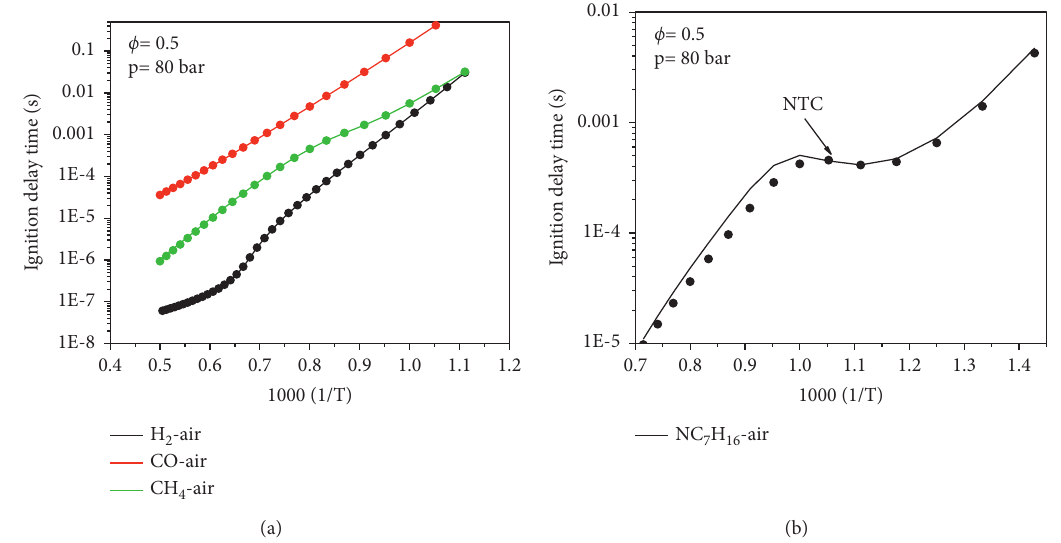
Figure 2: Comparison between the ignition delay time of the CSU mechanism (solid line) and the detailed mechanism (symbol) for single fuel at p � 80 bar and ϕ � 0.5. (a) NUIG [40] mechanism and CSU mechanism. (b) LLNL [41] mechanism and CSU